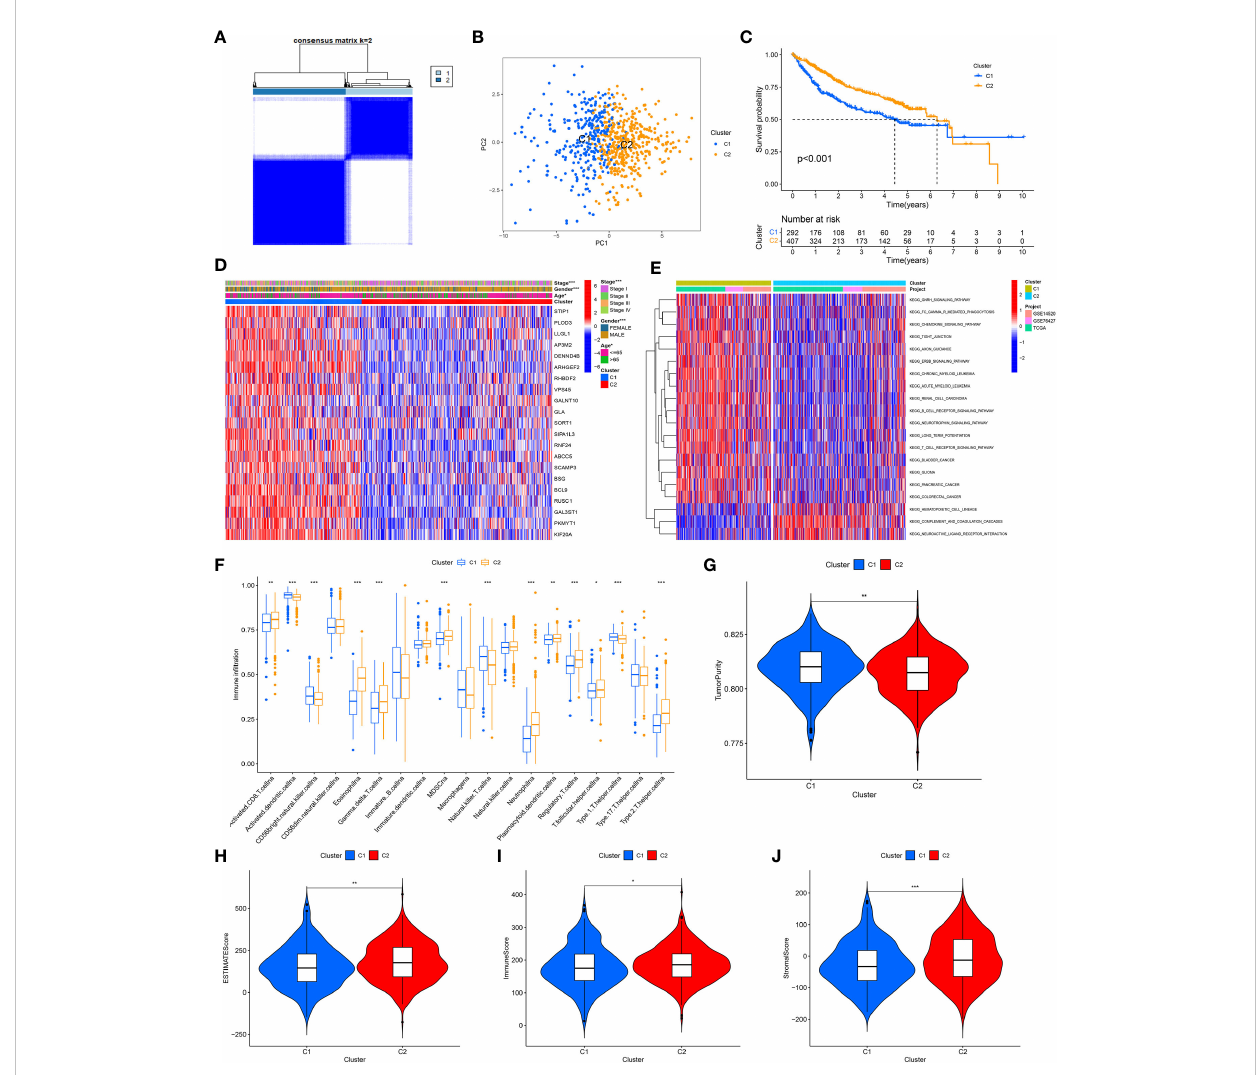
FIGURE 4 Identi fi cation of tumor subtypes based on the GARGs. (A) Two clusters were identi fi ed according to the best consensus matrix (k=2). (B) Principal Component Analysis (PCA) demonstrates the degree of differentiation between the two subtypes. (C) The overall survival between the two subtypes. (D) Comparison of GARGs expression and clinical characteristics between the two subtypes. (E) Gene Set Variation Analysis (GSVA) was performed to analyze the differences between the two subtypes. (F) The immune cell in fi ltration between the two subtypes was analyzed by the ssGSEA. (G) TumorPurity between the two subtypes. (H) ESTIMATEScore between the two subtypes. (I) ImmuneScore between the two subtypes. (J) StromalScore between the two subtypes. *P<0.05, **P<0.01,